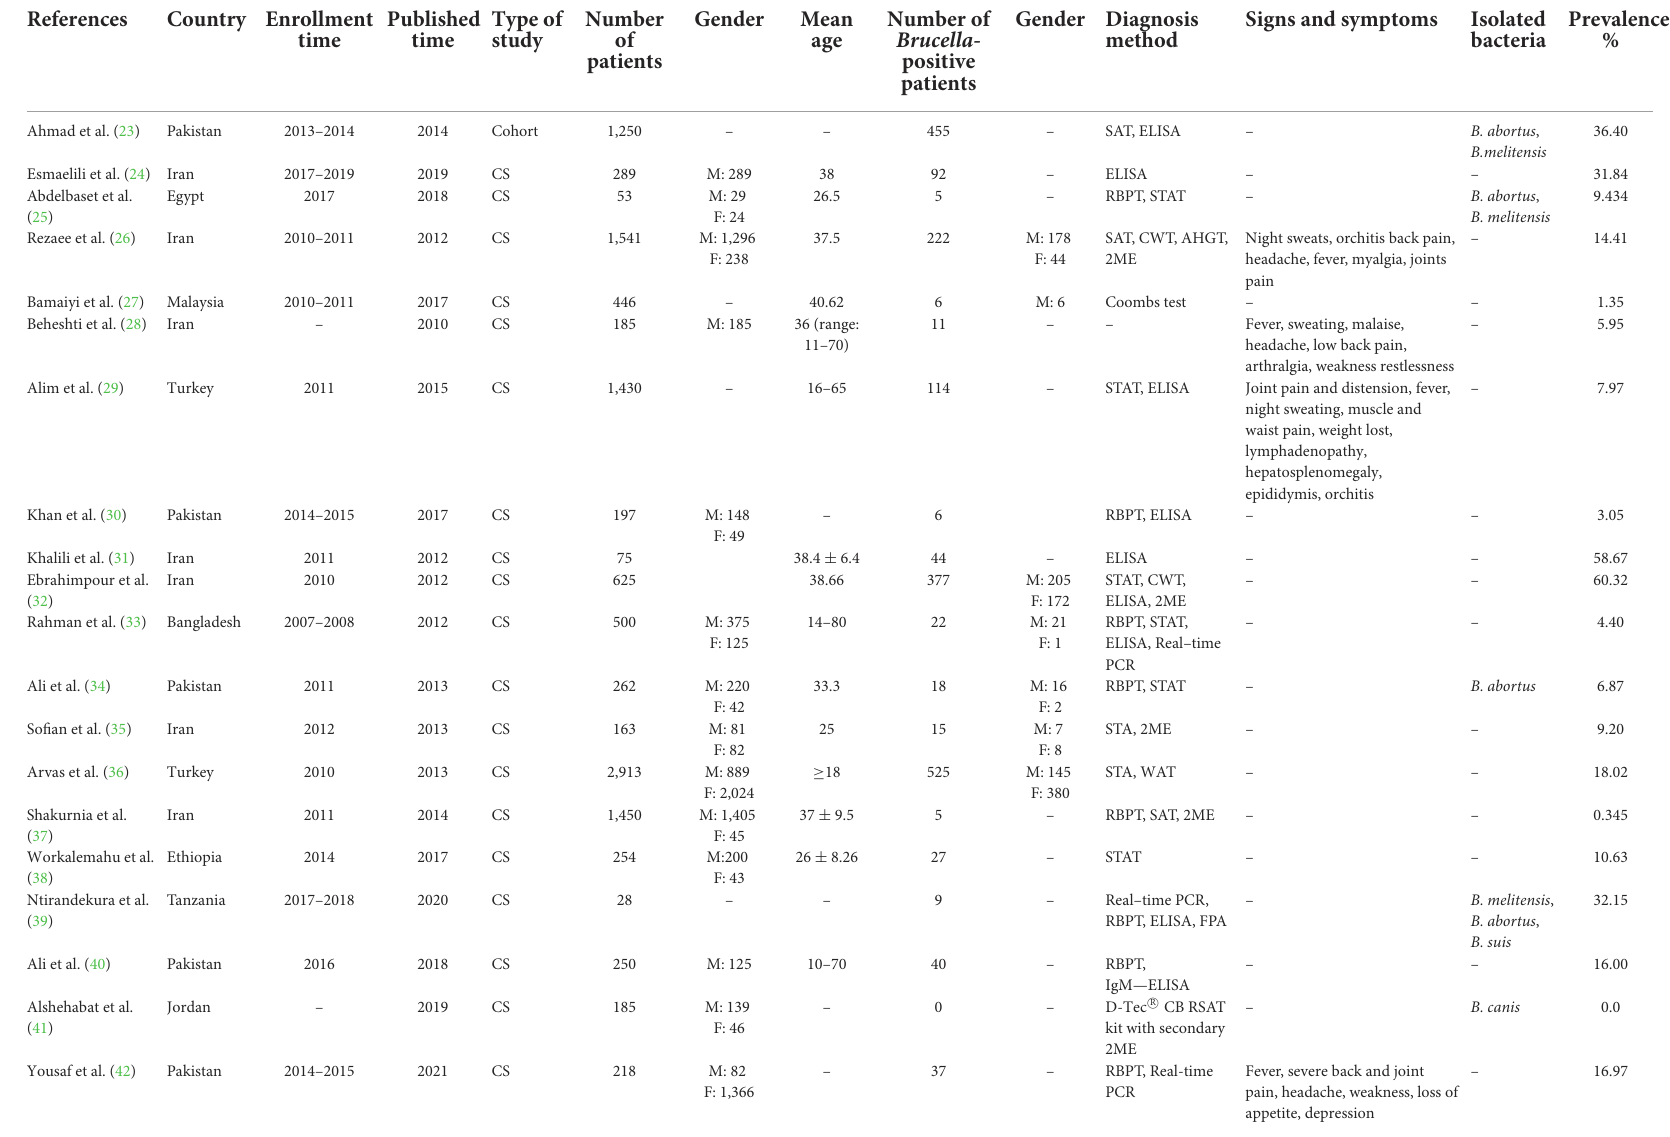
TABLE 1 Characteristics of studies included in this